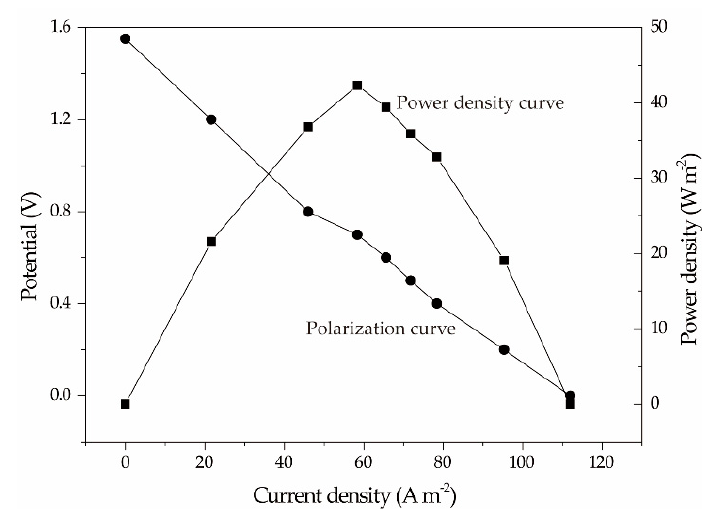
Figure 6. The polarization and power-density curves of the Al-H 2 O 2 FC utilizing the Ag NW//CC cathode. Table 1. Performance comparison of this work with selected micro-sized fuel cells reported in the literatures.